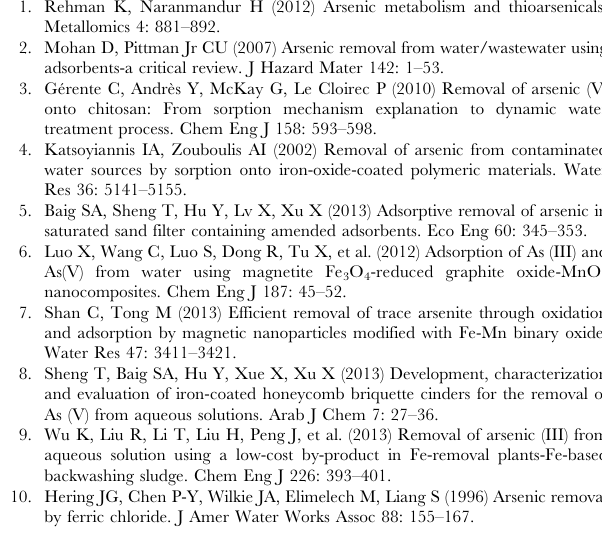
Figure S2 The variations in final or equilibrium pH of all the five adsorbents to remove As(V) (a) and As(III) (b) as a function of initial pH. (Experiment conditions: adsorbent dose = 0.02 g 100 mL 2 1 , temperature = 25 ± 0.8 6 C, agitation speed = 150 rpm, initial concentra- tion = 100 m g L 2 1 , contact time = 14 h). (TIF) Figure S3 (A and B) Pseudo-first-order (PFO) kinetics model for As(V) and As(III), (C and D) Pseudo-second- order (PSO) kinetics model of the adsorbent: a) Fe 3 O 4 - HBC uncalcined, b) 400 6 C under air, c) 400 6 C under nitrogen, d) 1000 6 C under air, e) 1000 6 C under nitrogen (Experiment conditions: initial concentraion = 100 m g L 2 1 , adsorbent dose = 0.02 g 100 mL 2 1 , pH 7, temper- ature = 25 ± 0.8 6 C). (TIF) Table S1 Percentage (%) removal of As(V) and As(III) at different temperatures on calcined and uncalcined adsorbent composite. (Experimental conditions: adsor- bent dose =0.02 g 100 mL 2 1 , pH = 7.0, agitation speed = 150 rpm, initial concentration = 100 m g L 2 1 , contact time = 14 h).